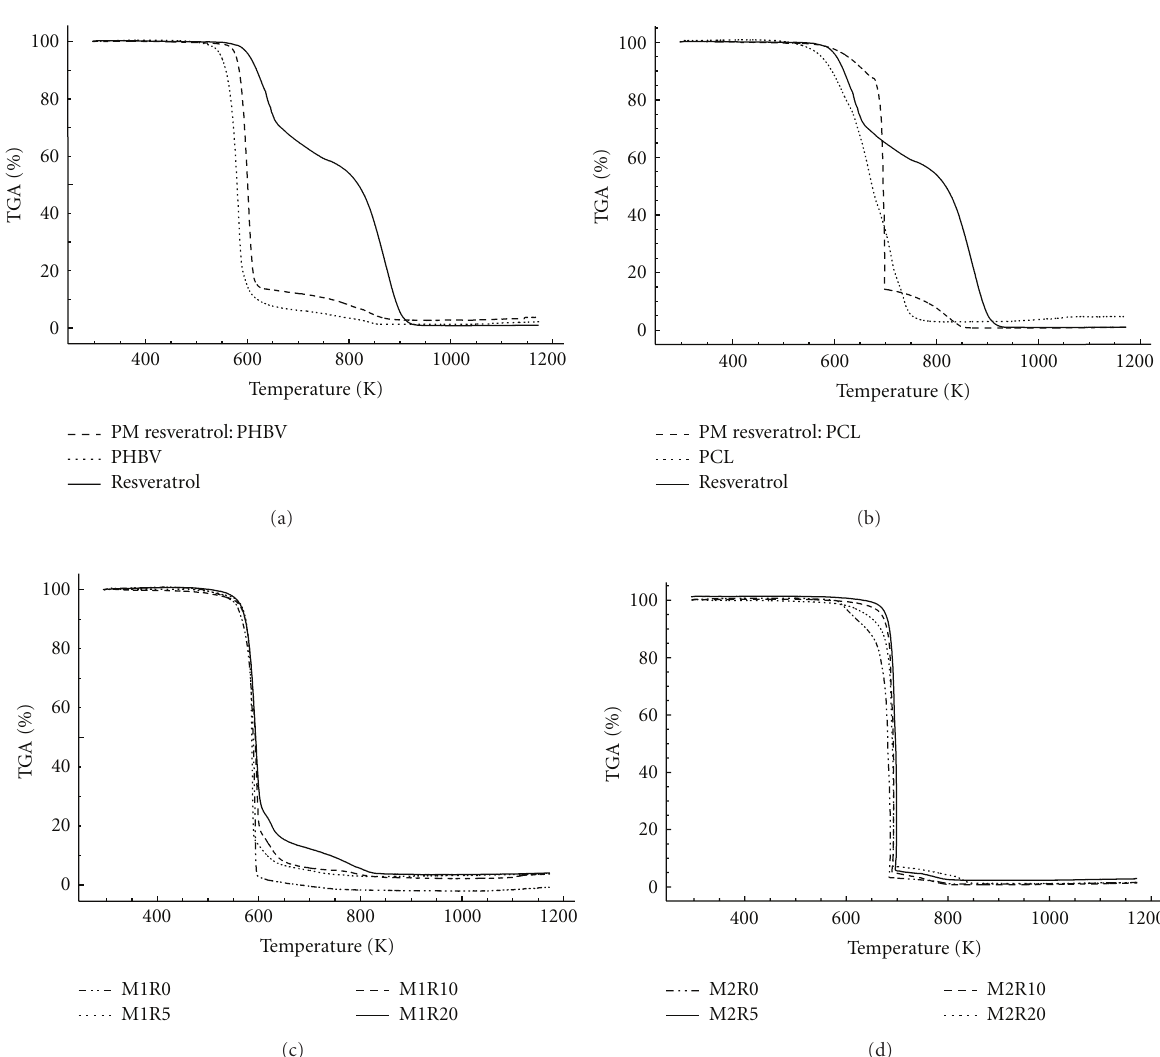
M1R5, M1R10, and M1R20, respectively. Otherwise PCL